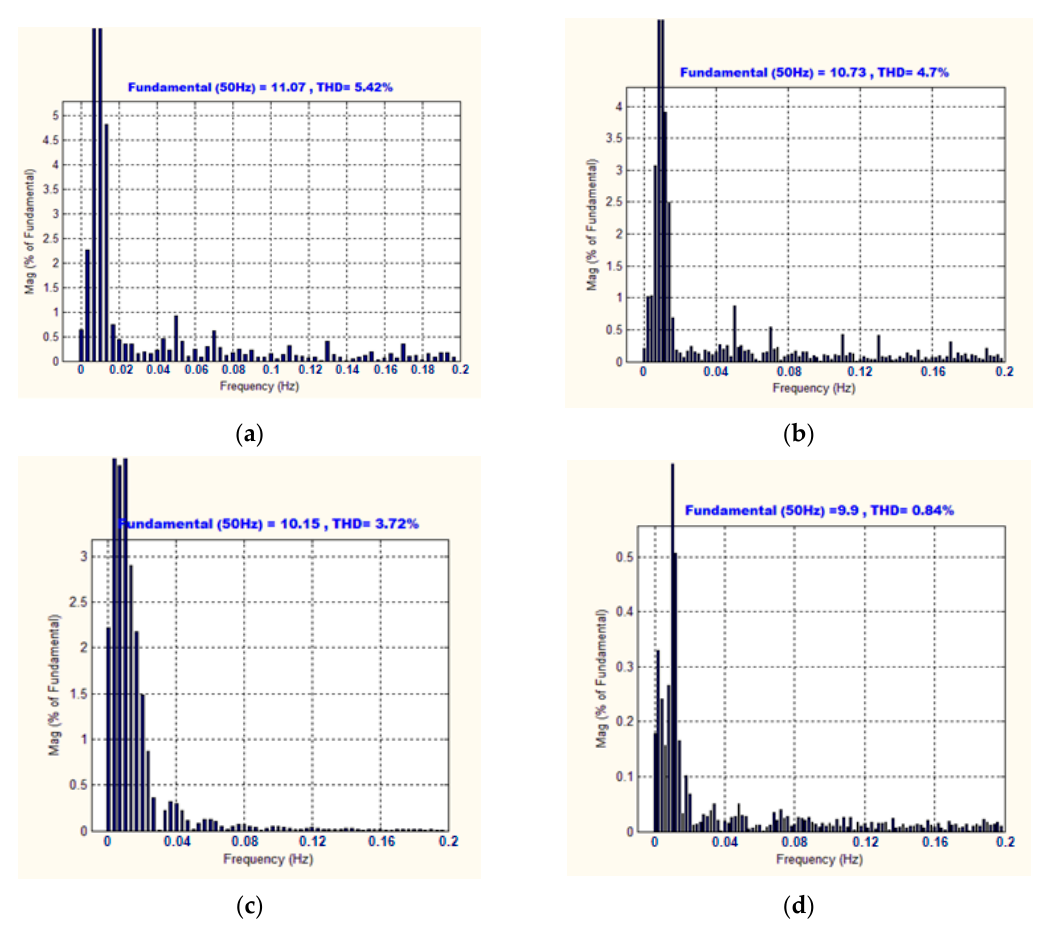
Figure 14. Source current THD with ( a ) PI ( b ) Fuzzy ( c ) ANN without genetic algorithm (GA)–RBFNN ( d ) ANN incorporated with GA–RBFNN.